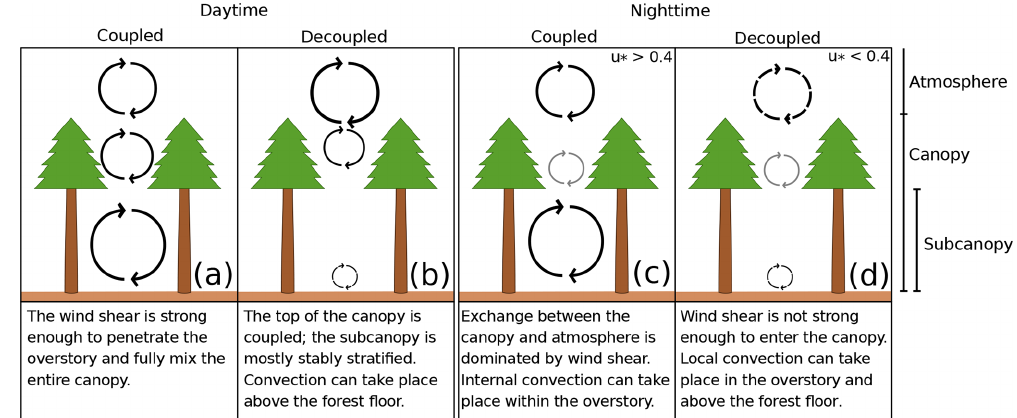
Figure 10. Typical exchange regimes observed at the Speulderbos site. The cyclic arrows denote convection or non-local